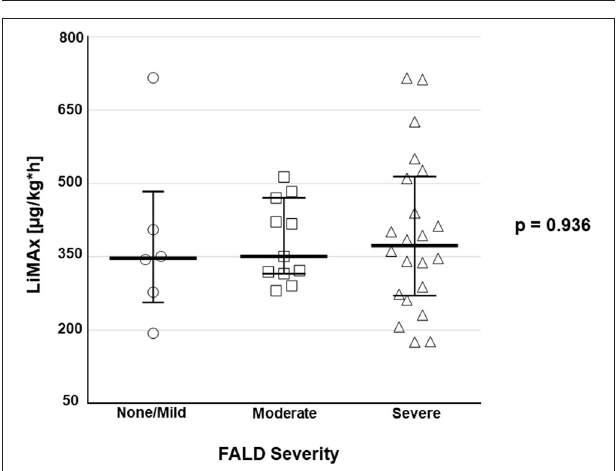
FIGURE 2 | Boxplots depict maximal liver function capacity according to the classification of FALD severity [absent/ mild ( n = 6), moderate ( n = 11), severe ( n =